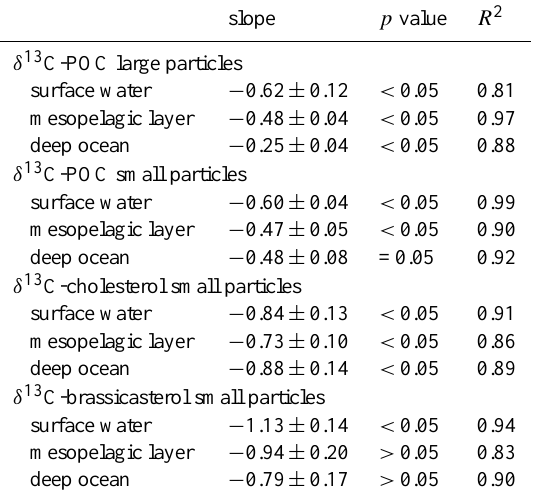
Table 2. Slope, standard error, p value and R 2 for variation of δ 13 C (‰), POC large particles, small particles, cholesterol and brassicast- erol in small particles vs. surface CO 2 aq. content, for the arbitrarily defined surface water (0–100m), mesopelagic layer (100–1000m) and deep ocean